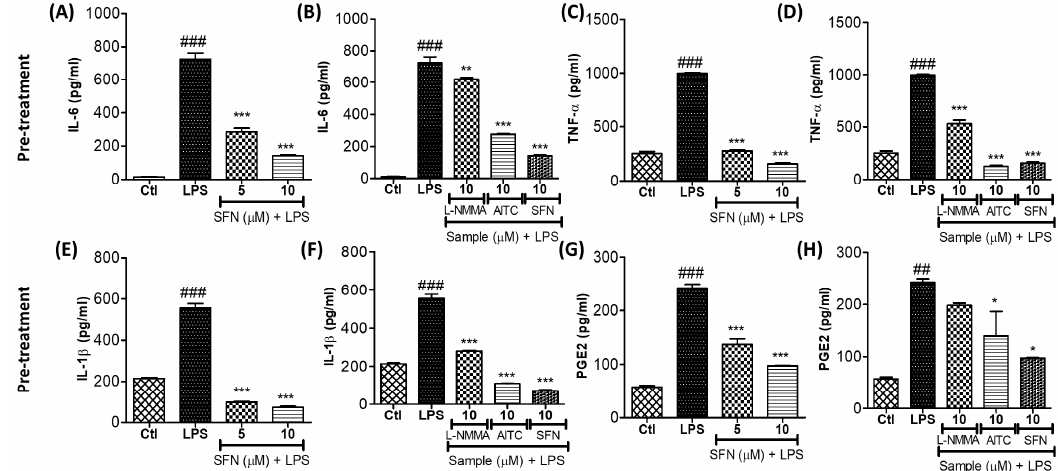
Figure 7. SFN inhibited proinflammatory cytokine production in LPS-activated BV2 microglial cells. The cells were pre-treated with SFN, L -NMMA, or AITC for 30 min and then stimulated with LPS (100 ng/mL). Proinflammatory cytokines in the conditioned medium of the treated cells were measured by ELISA after 24 h of LPS activation. Secretion of ( A , B ) IL-6, ( C , D ) TNF- α , ( E , F ) IL-1 β , and ( G , H ) PGE2 after SFN, L -NMMA, or AITC treatment. All data are presented as the mean ± standard error of the mean of three independent experiments. * p < 0.05, ** p < 0.01, and *** p < 0.001 indicate significant differences compared with LPS treatment alone; ### p < 0.001 indicates significant differences compared with the untreated control group. Ctl—untreated control cells; LPS—cells treated with lipopolysaccharide only.